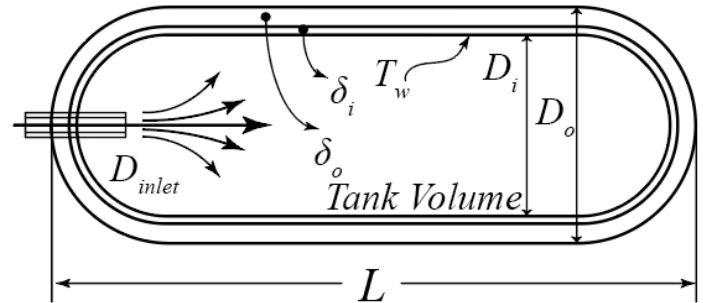
Figure 1. Schematic diagram of the geometric model. Table 1. Dimensions of the geometric model [13,27].